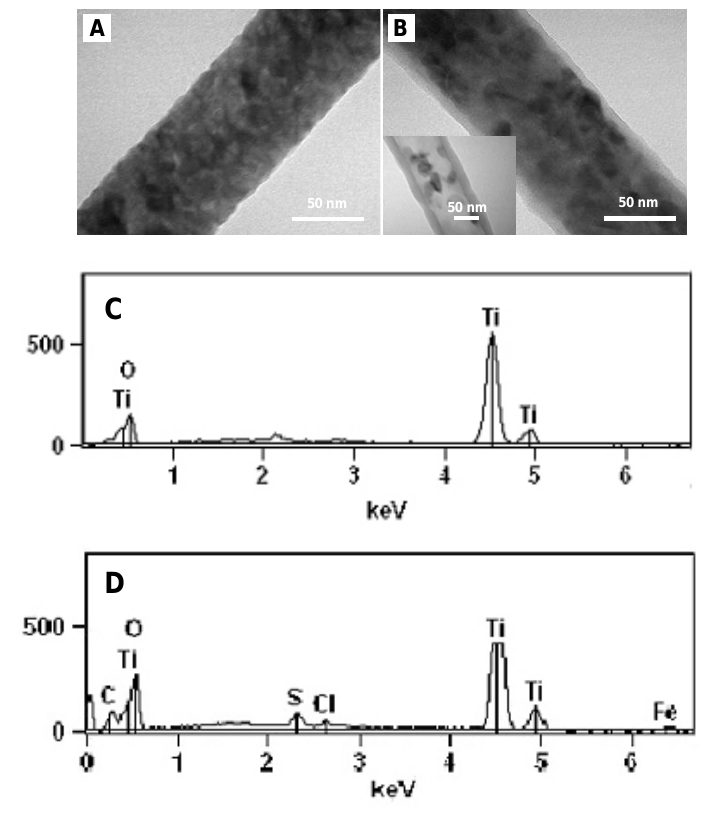
Figure 2. ( A) TEM image of an individual TiO -PEDOT nanocable. The inset shows PEDOT nanotube obtained by selectively sheath TiO 2 removing TiO core in 5 mol/L HF aqueous solution. (C) EDX element analysis result for 2 TiO nanofibers. (D) EDX element analysis result for TiO 2